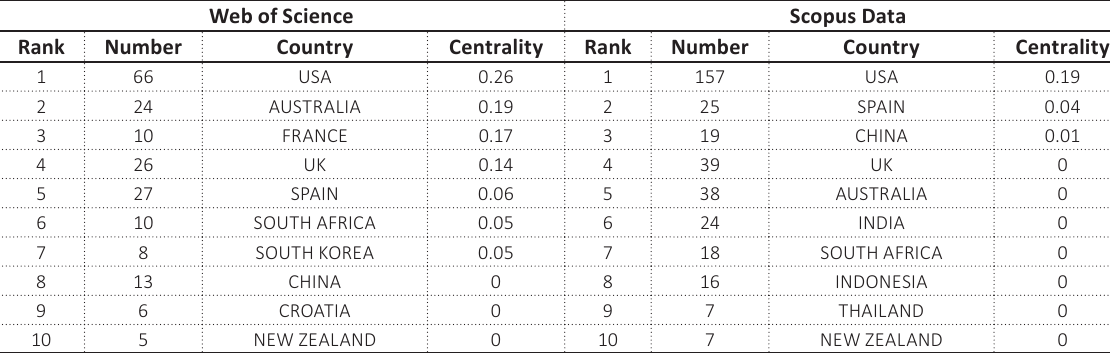
Table 2. Country contributions to IMC research